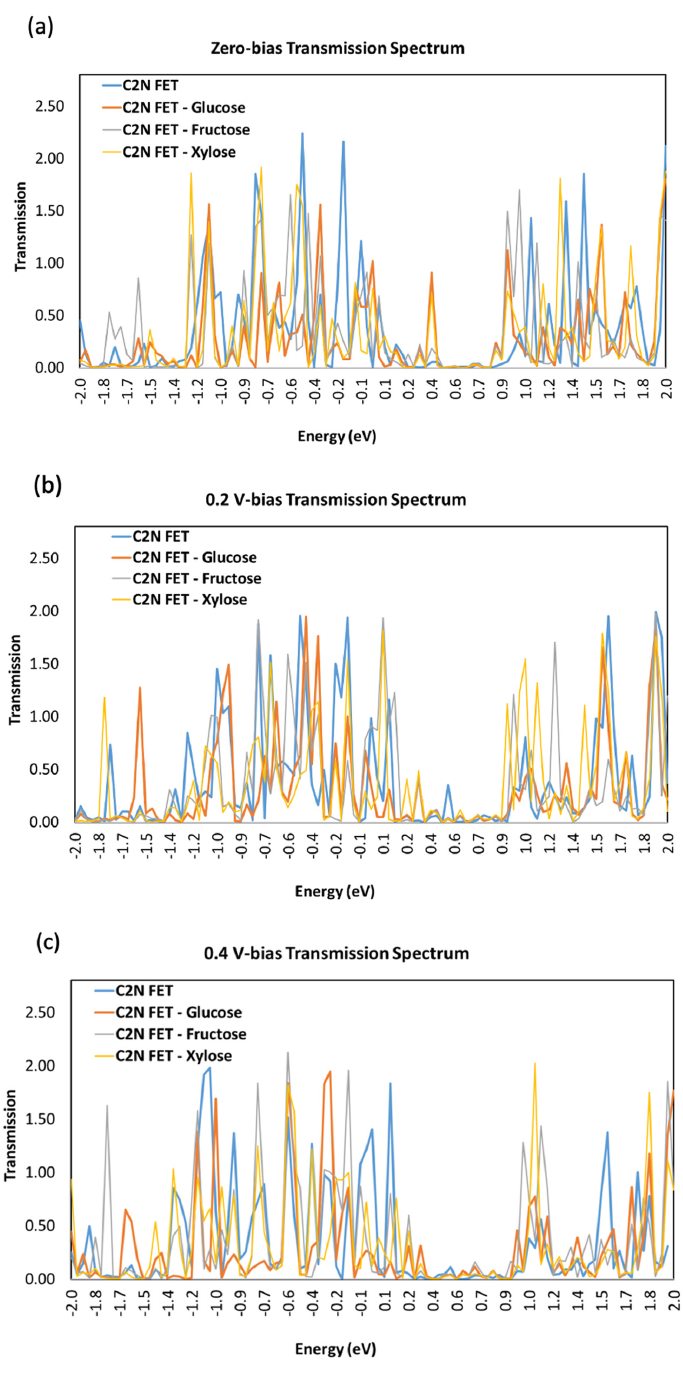
Figure 7. Transmission spectra T(E) for C 2 N-FET sensor with three different sugar molecules ( a ) bias voltage = 0 V, ( b ) bias voltage = 0.2 V, and ( c ) bias voltage = 0.4 V.